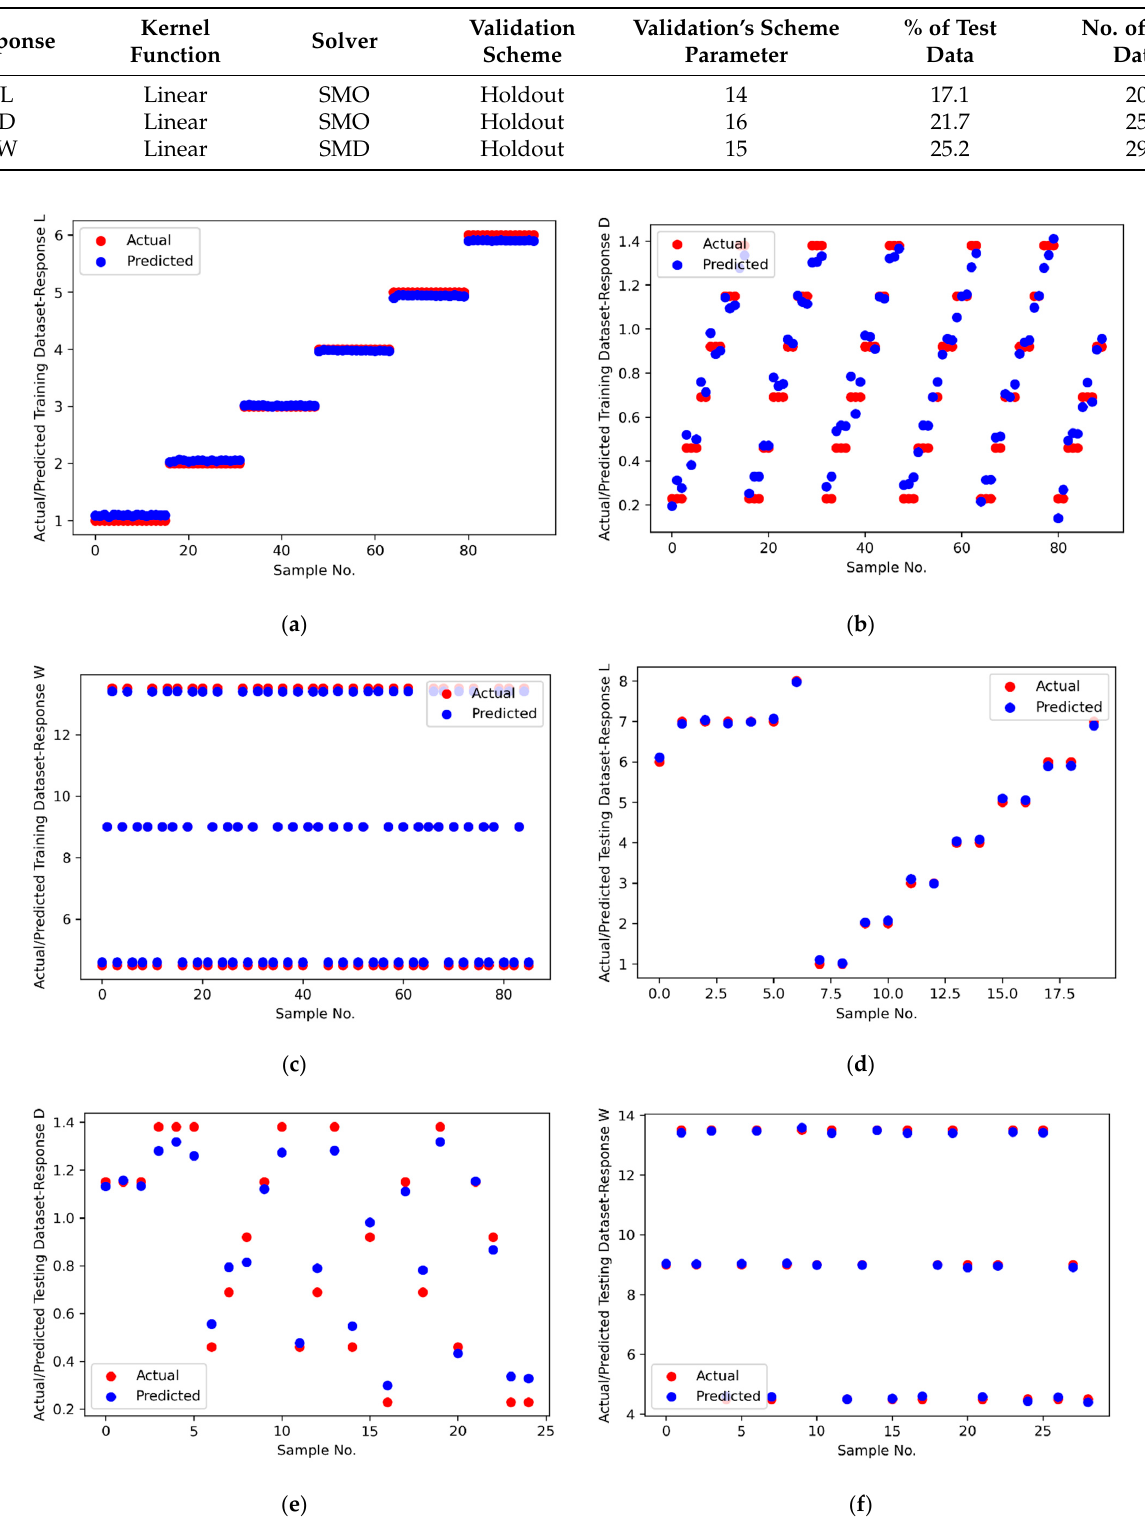
Figure 6. Comparison of actual and predicted values for ( a ) Training Dataset-Response L; ( b ) Training Dataset-Response D; ( c ) Training Dataset-Response W; ( d ) Testing Dataset-Response L; ( e ) Testing Dataset-Response D; ( f ) Testing Dataset-Response W.